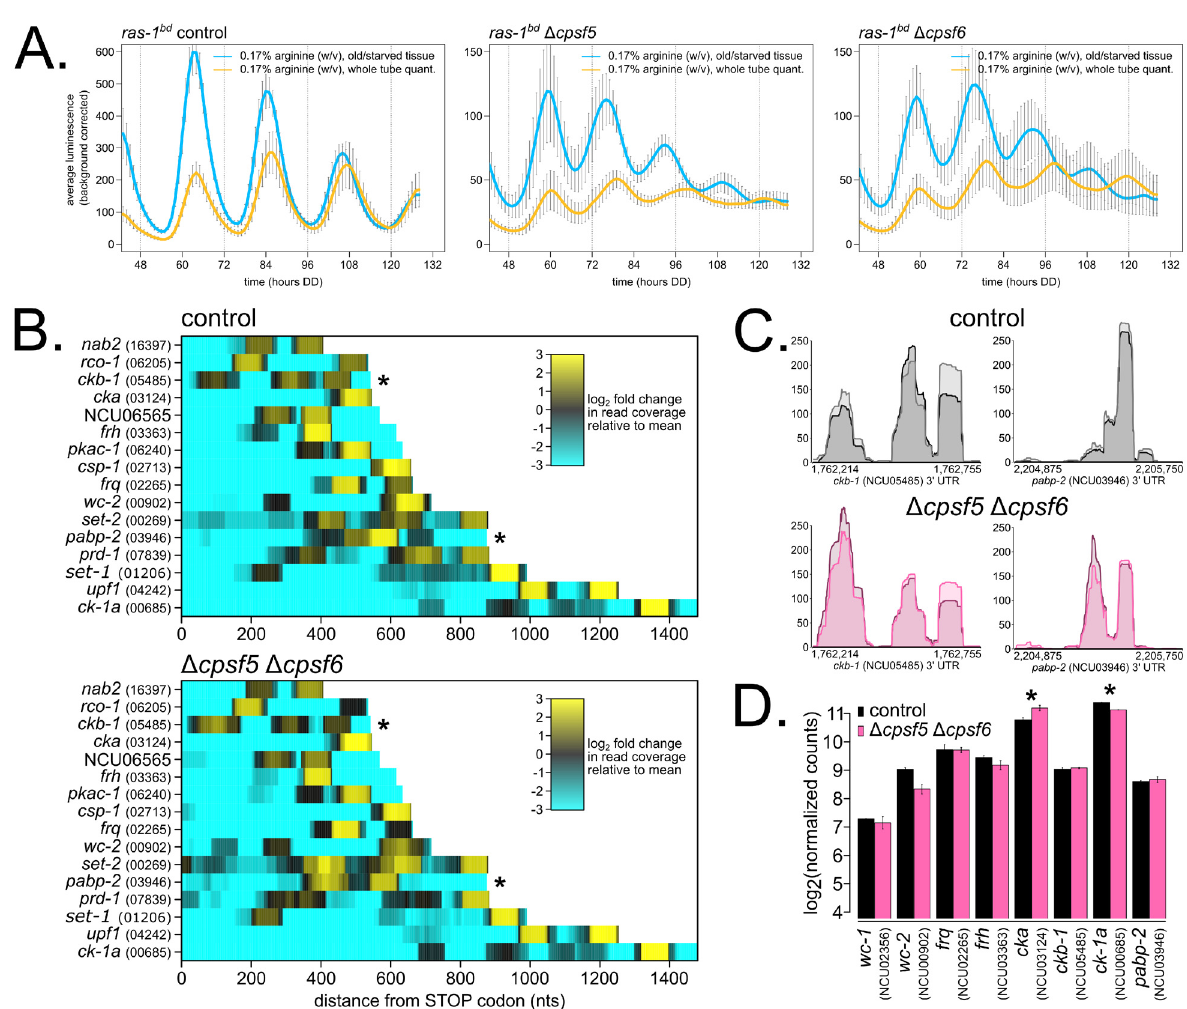
Fig 4. The Neurospora CFIm complex is involved in Alternative Polyadenylation (APA), and a subset of core clock and compensation-relevant genes are altered in Δ CFIm mutants. Circadian bioluminescence was recorded from race tube cultures of the indicated strains grown in high amino acid race tube medium (0.17% w/v arginine, 0% glucose). Luciferase signal was acquired from the entire race tube of fungal growth (yellow lines) or from an old tissue region of the race tube (blue lines) (see S2 Movie) (standard deviation error bars). Circadian period lengths were computed for each region (Materials and methods; N = 4 race tubes per genotype): control: 21.7 ± 0.2 hours (whole tube), 21.4 ± 0.3 hours (old tissue); Δ cpsf5 : 19.0 ± 0.5 hours (whole tube), 17.2 ± 0.2 hours (old tissue); Δ cpsf6 : 19.4 ± 0.3 hours (whole tube), 17.3 ± 0.3 hours (old tissue) ( A ). Wild-type control and Δ cpsf5 Δ cpsf6 double mutant cellophane plate cultures were grown in constant light at 25˚C for 72 hours on high nutrient medium (0.25% w/v glucose, 0.17% w/v arginine). Total RNA was extracted, and 3 0 End Sequencing was performed ( N = 2 biological replicates per genotype). Sixteen core clock and compensation genes of interest were selected, read pileup data from 3 0 UTR regions were extracted, biological duplicate samples averaged together, and heatmaps were generated. Read count pileups are depicted as log 2 -fold changes, and both color scales are normalized to mean counts in the wild-type dataset. Each point along the x-axis represents nucleotide coordinates from the STOP codon for each mRNA (where data from any negative/Crick strand genes are shown in reverse orientation), and genes are ordered along the y-axis by increasing 3 0 UTR lengths. Asterisks ( � ) indicate two genes, ckb-1 and pabp-2 , with significantly altered APA patterns between control and mutant ( B ). Genomic tracks were generated using the Gviz package in R to visualize poly(A) read pileups in the 3 0 UTR regions of ckb-1 and pabp-2 . In the Δ CFIm mutant, poly(A) tail locations are significantly changed for ckb-1 and pabp-2 ( C ). Gene expression levels of core clock and compensation genes were measured by normalizing total read counts for each gene (Materials and methods). Log 2 -transformed read counts are shown. Asterisks indicate p < 0.05 ( � ) by Student t test comparing mutant to control levels. The cka prd-3 transcript is 1.34-fold up-regulated, and the ck-1a transcript is 1.2-fold down-regulated in Δ CFIm ( D ). The raw data underlying parts ( A ) and ( D ) can be found in S4 Data.